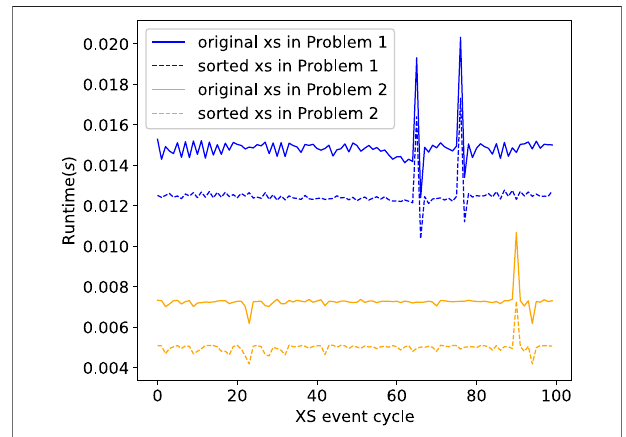
FIGURE 6 | Runtime of original and sorted xs kernel on Problem 1 and Problem 2. The x -axis represents the number of xs events in the execution of